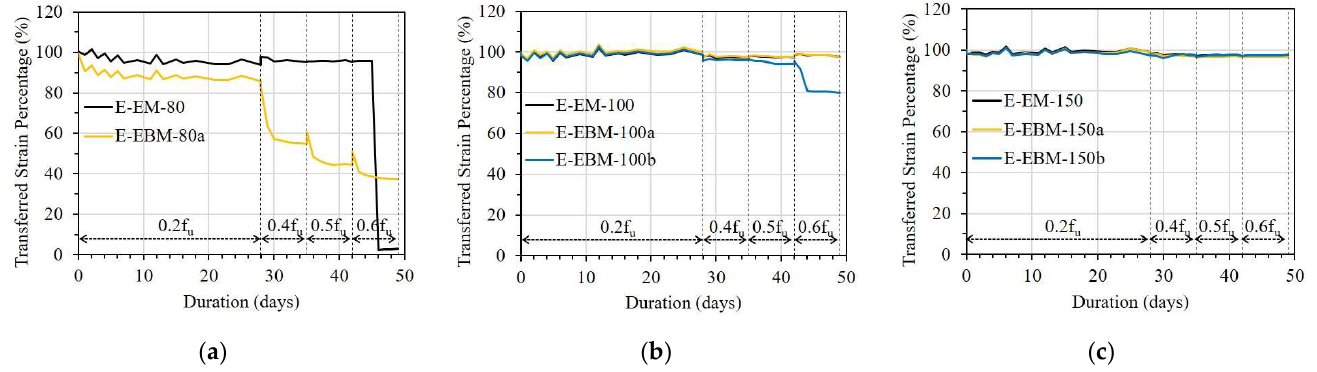
Figure 13. Short-term creep effect on strain transfer of the E specimen with different bonding meth- ods: ( a ) L = 80 mm; ( b ) L = 100 mm; and ( c ) L = 150 mm.